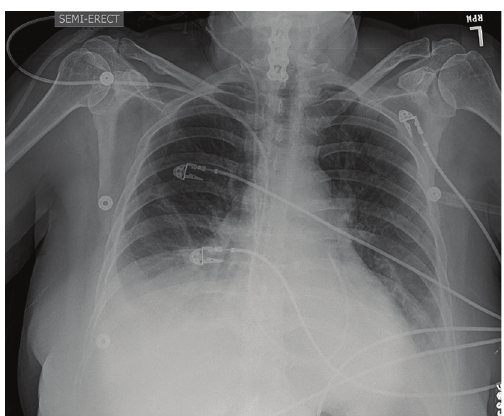
Figure 2: Chest plain film on presentation demonstrating likely pulmonary edema without